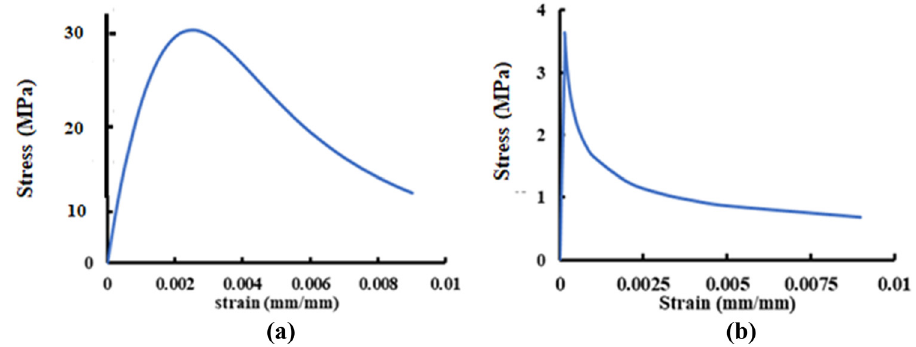
Figure 2: Concrete uniaxial compressive and tensile stress – strain curves. ( a ) In compressive and ( b ) in tension.